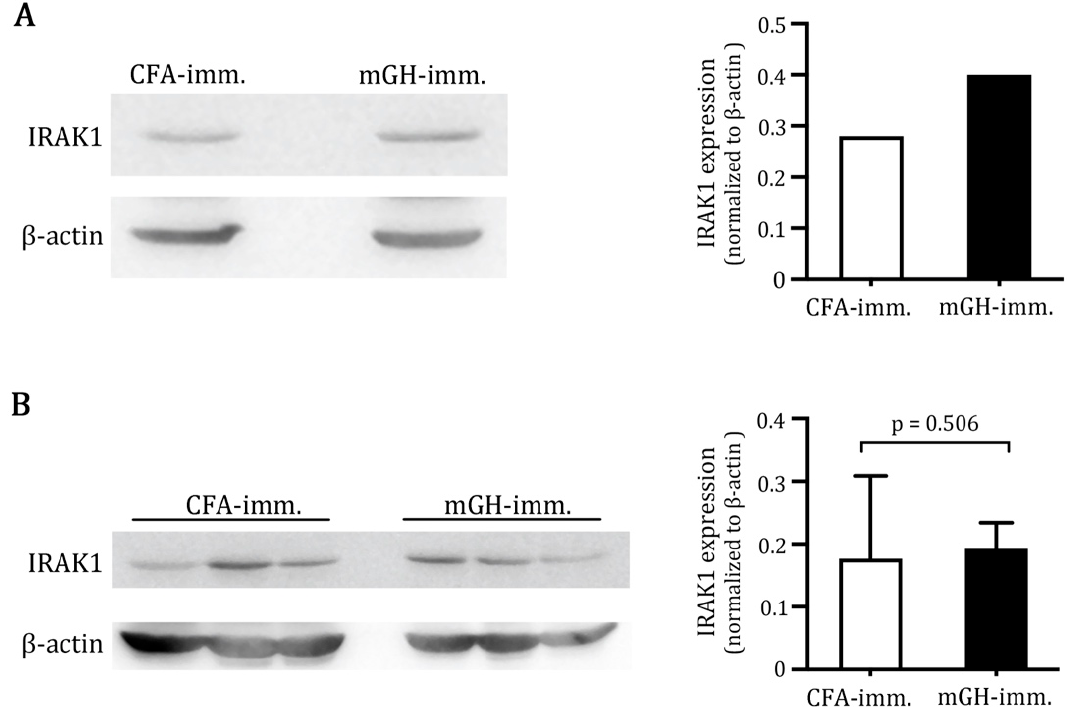
Figure 1 . IRAK1 expression in EAH. ( A ) Pituitary lysates of CFA-immunized and mGH-immunized mice were analyzed for IRAK1 expression by western blot using an IRAK1 antibody. ( B ) Inguinal lymph node lysates from CFA-immunized and mGH-immunized mice were analyzed for IRAK1 expression by western blot using an IRAK1 antibody.